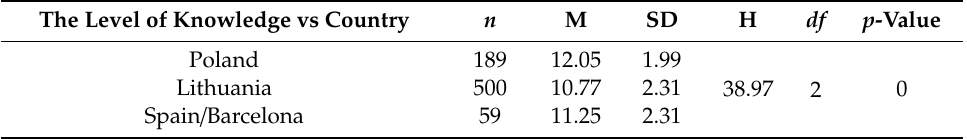
Table 4. The multiple comparison between three countries—the level of knowledge about BLS. The Level of Knowledge vs Country n M SD H df p -Value Poland